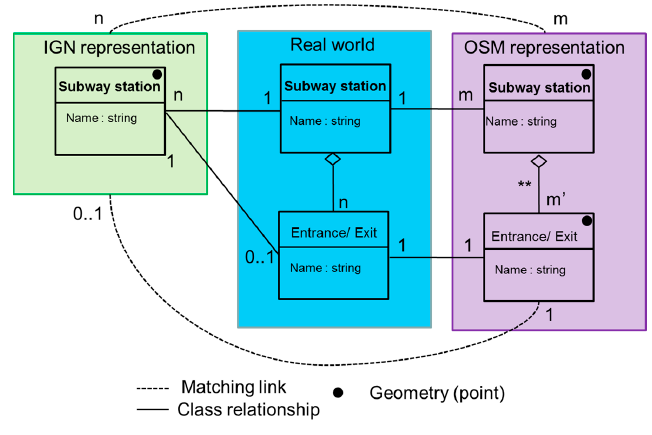
Figure 9. Representation of subway stations in OSM and IGN datasets.